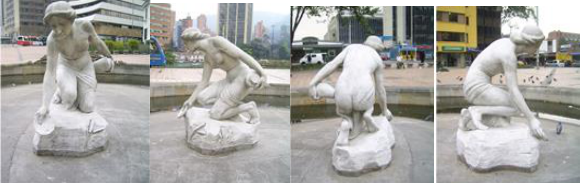
Figure 1. Taking photographs front, side and back of the Sculpture La